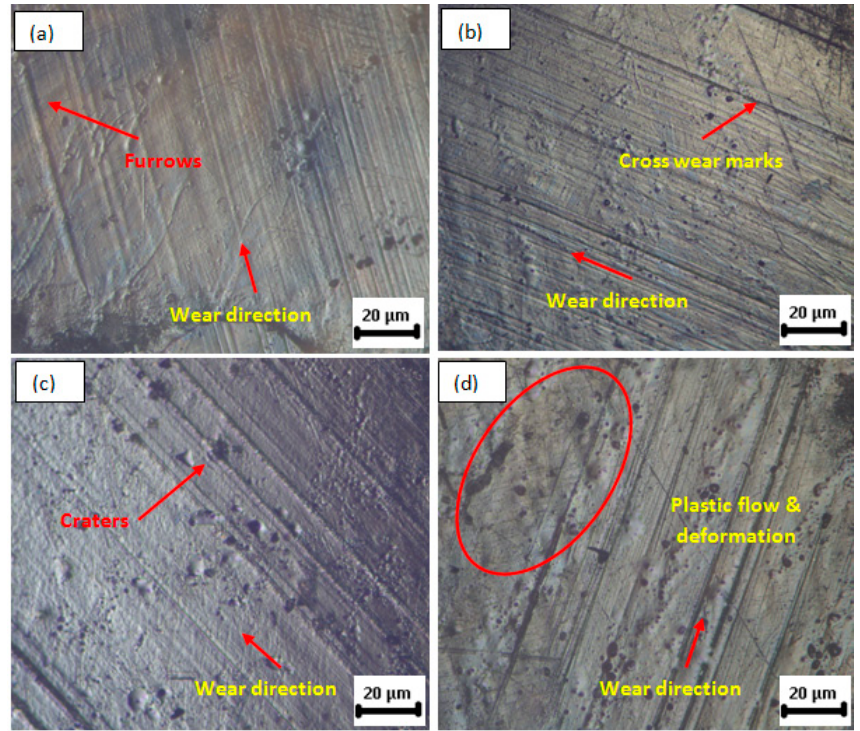
Figure 7. Optical microscope images of test sample (2 wt % UHMWPE/MWCNT nanocomposites with 60 min plasma treatment) under N-Saline lubricant sliding conditions. ( a ) Furrows and wear direction; ( b ) cross-wear marks; ( c ) craters; and ( d ) plastic flow and deformation.